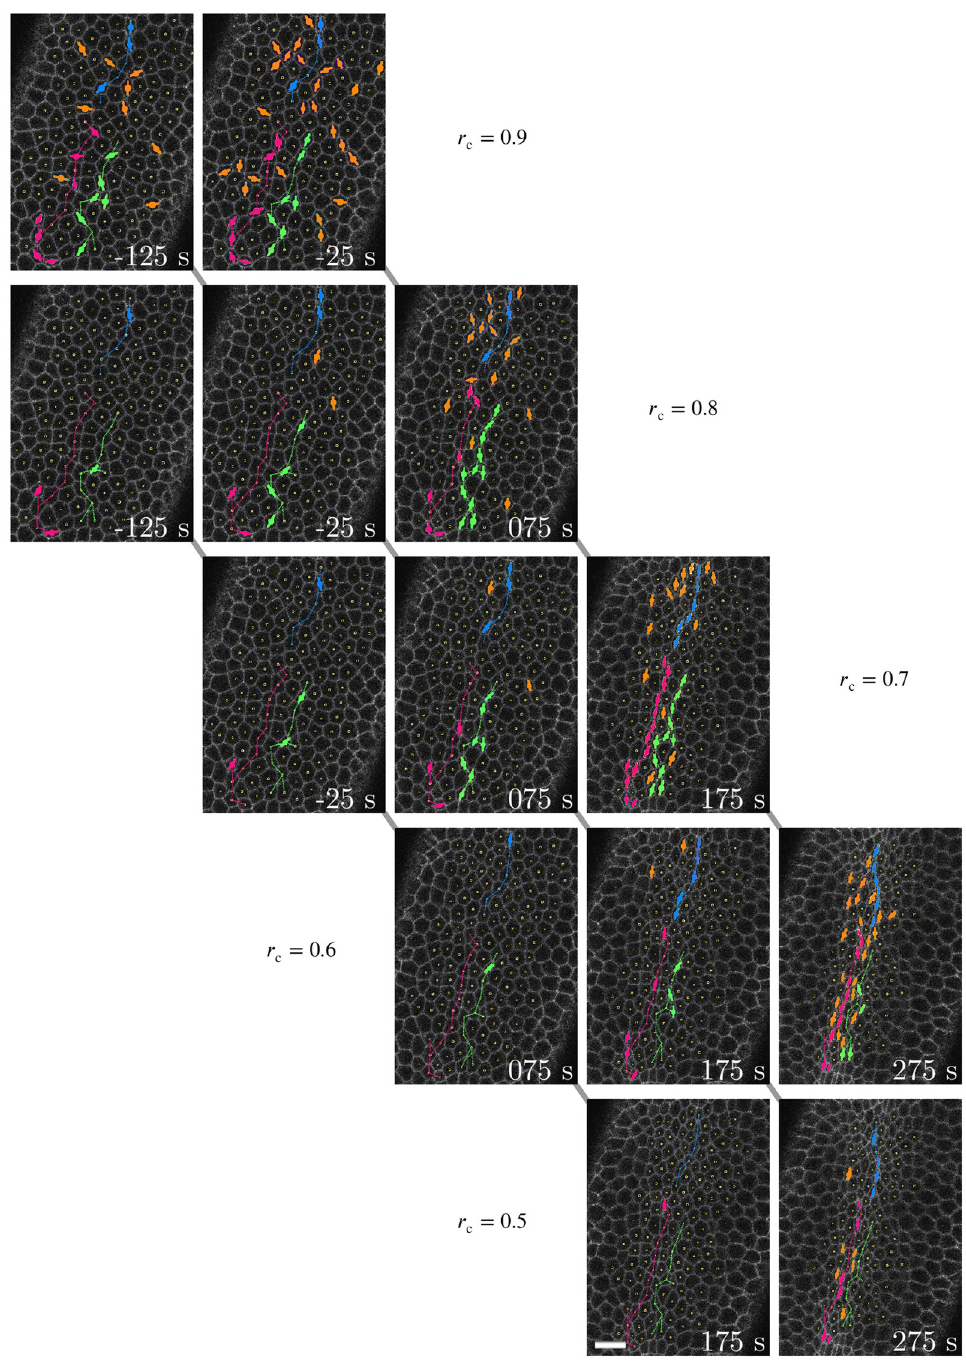
Fig 3. Comparison of cellular-constriction chain progression with respect to time and degree of constriction. Processed images showing the apical constriction phase of VFF in a single Spider-GFP Drosophila embryo using different minor-axis reduction thresholds r c (as labeled). Symbols per Fig 2. Time-lapse sequences in different rows indicate that CCC development is similar between a stronger r c and a weaker r c at an earlier time. Notable chains that persist between different r c strengths are demarcated in either pink, green, or blue and indicated by thin lines. Scale bar: 10 μ m.